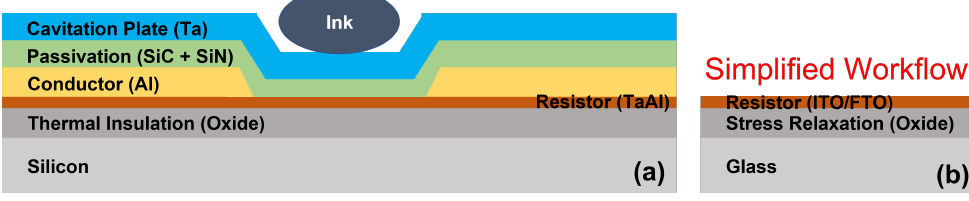
Figure 1. TMP Thin Film Stack—( a ) illustrates the standard micro-fabrication thin film stack used in TMP resistors to heat ink which is based on thermal inkjet (TIJ) technology [21]. The stack is built on a silicon substrate followed by a thermal insulation layer, a resistive layer, a conductive layer, electrical passivation layers, and a cavitation plate. ( b ) shows the simplified commercial thin film stack used in this study for rapid fabrication of TMP